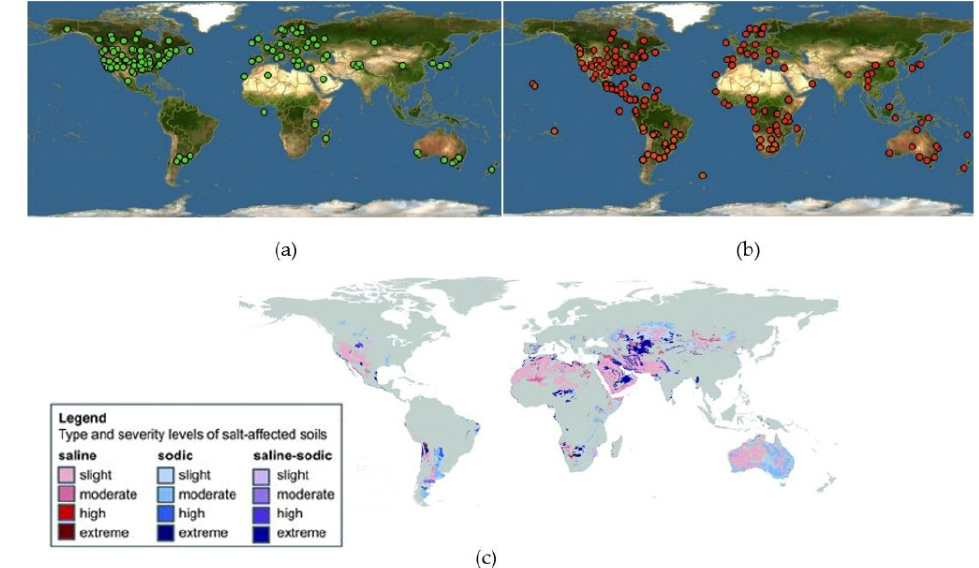
Figure 1. Global distribution of Amaranthus albus ( a ) and A. hybridus ( b ) , modified from Discover Life (https://www.discoverlife.org/20/, accessed on 11 April 2022). Areas affected by salinity worldwide; occurrence of saline, sodic and saline-sodic soils ( c ) according to the Encyclopedia of the Environment (https://www.encyclopedie-environnement.org/en/zoom/land-salinization/, accessed on 11 April 2022).